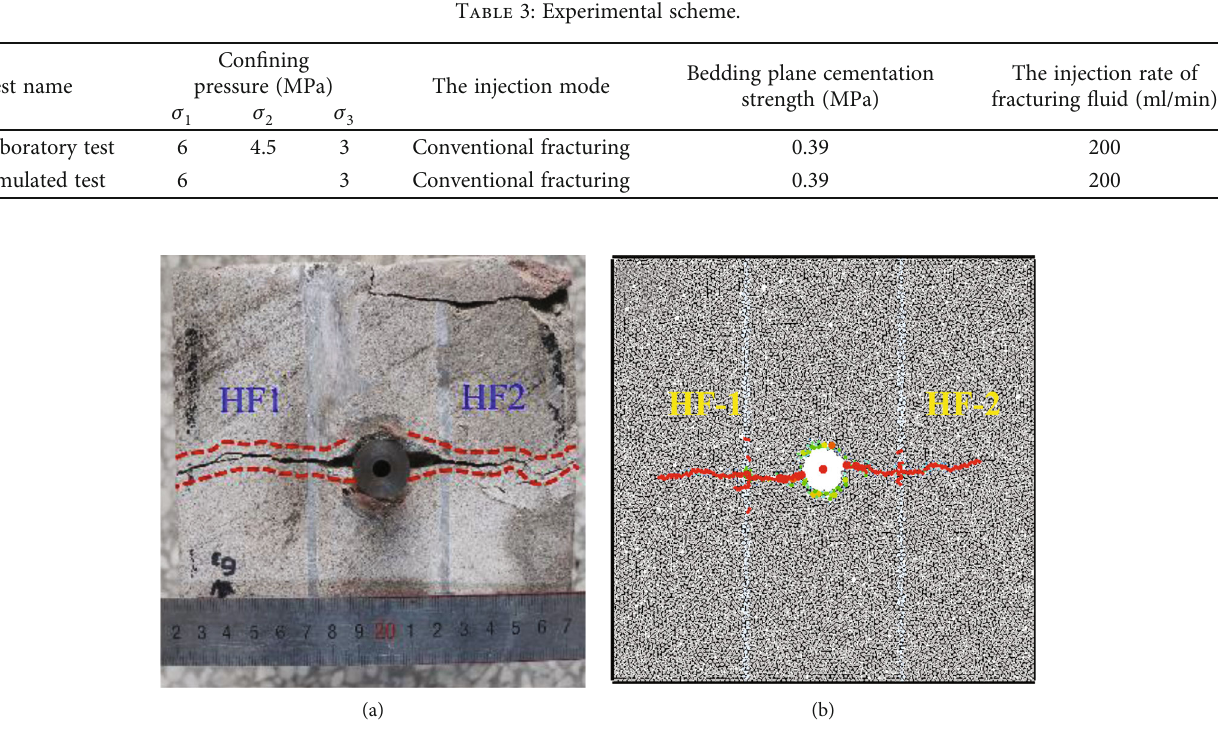
Figure 5: Hydraulic fracture morphology: (a) laboratory test; (b) simulated test. Table 4: Experimental scheme for hydrofracturing under di ff erent injection rates.